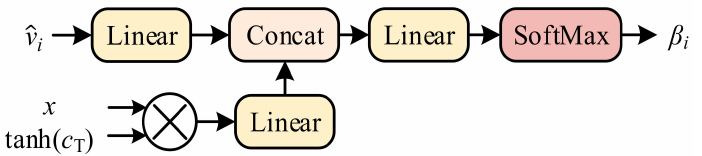
Figure 3. The WGW module in the WGA, where the embedded word and memory cell refine the feature vectors by strengthening the connection with existing